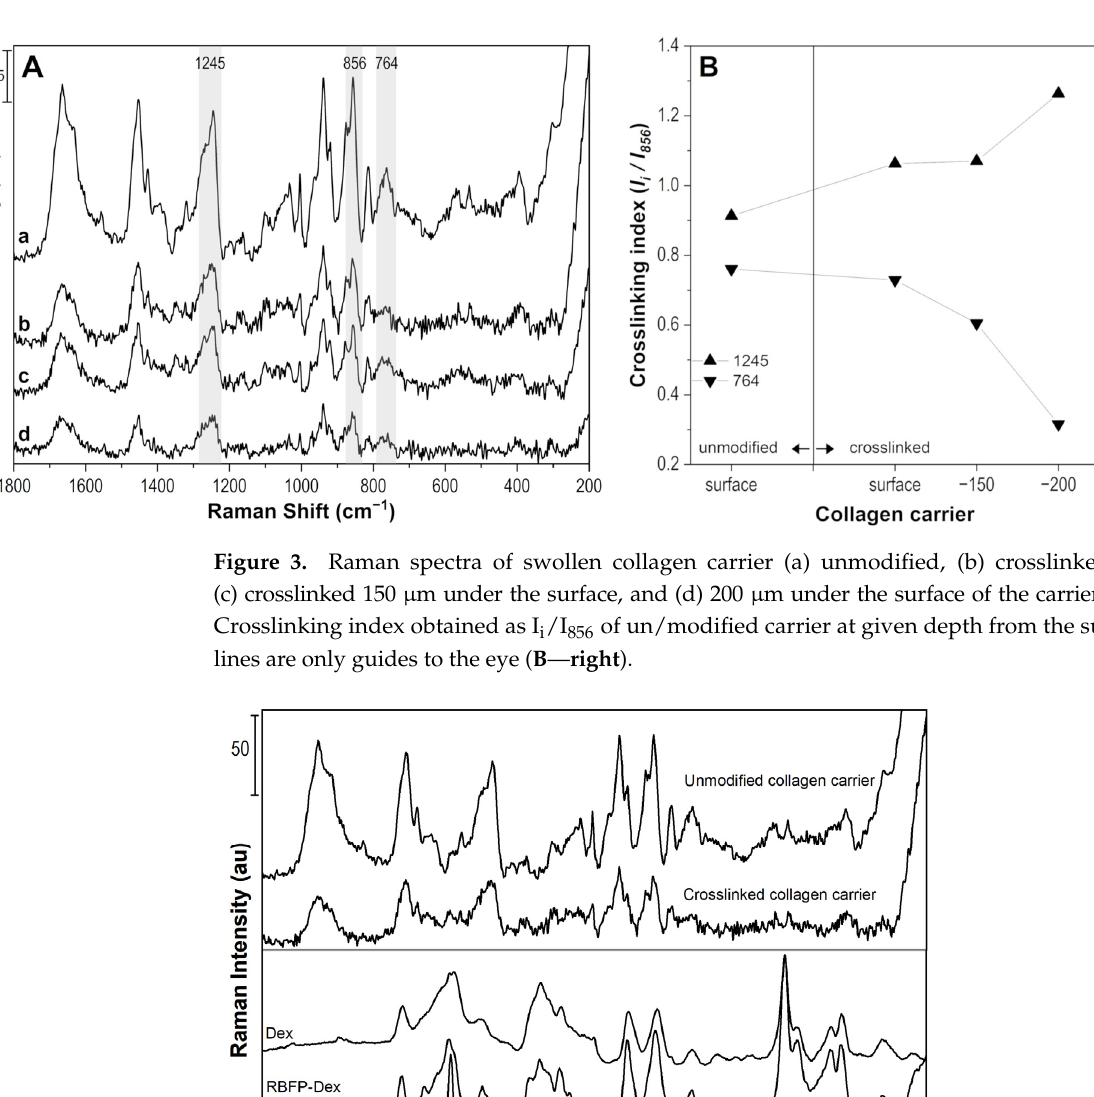
Figure 4. Raman spectra of swollen collagen carrier (unmodified and crosslinked) and dextran (Dex), riboflavin phosphate (RBFP) and the solution of RBFP in Dex.